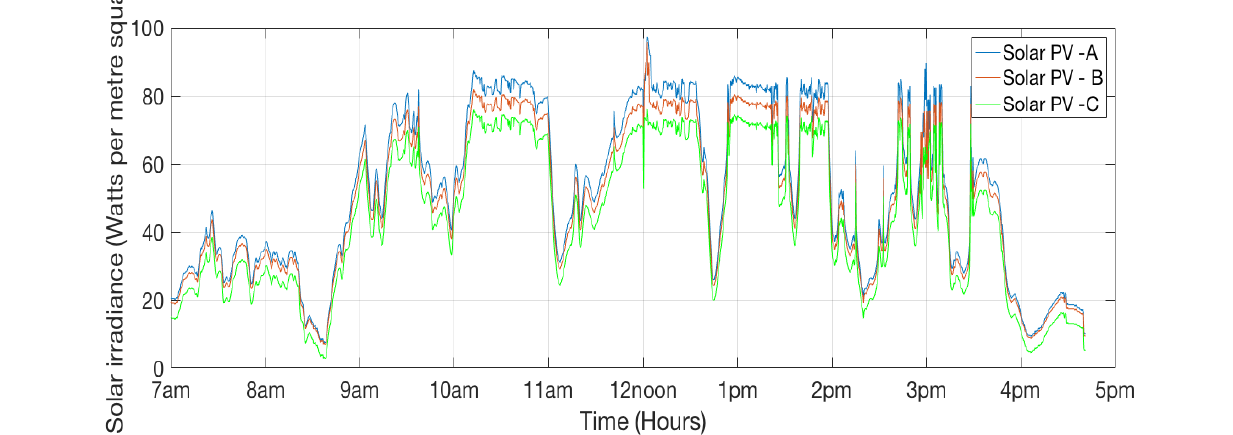
Figure 14. The charts of average